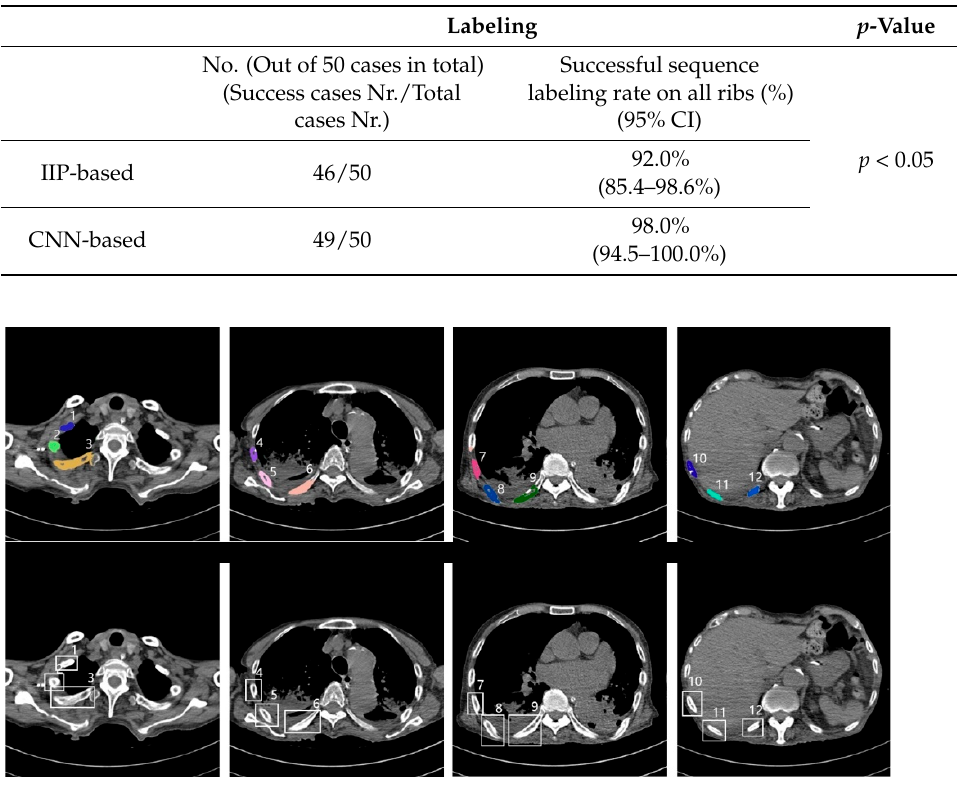
Table 2. Comparison of the sequence labeling systems based on IIP and CNN in terms of successful labeling rate; ( p -value, a probability value).